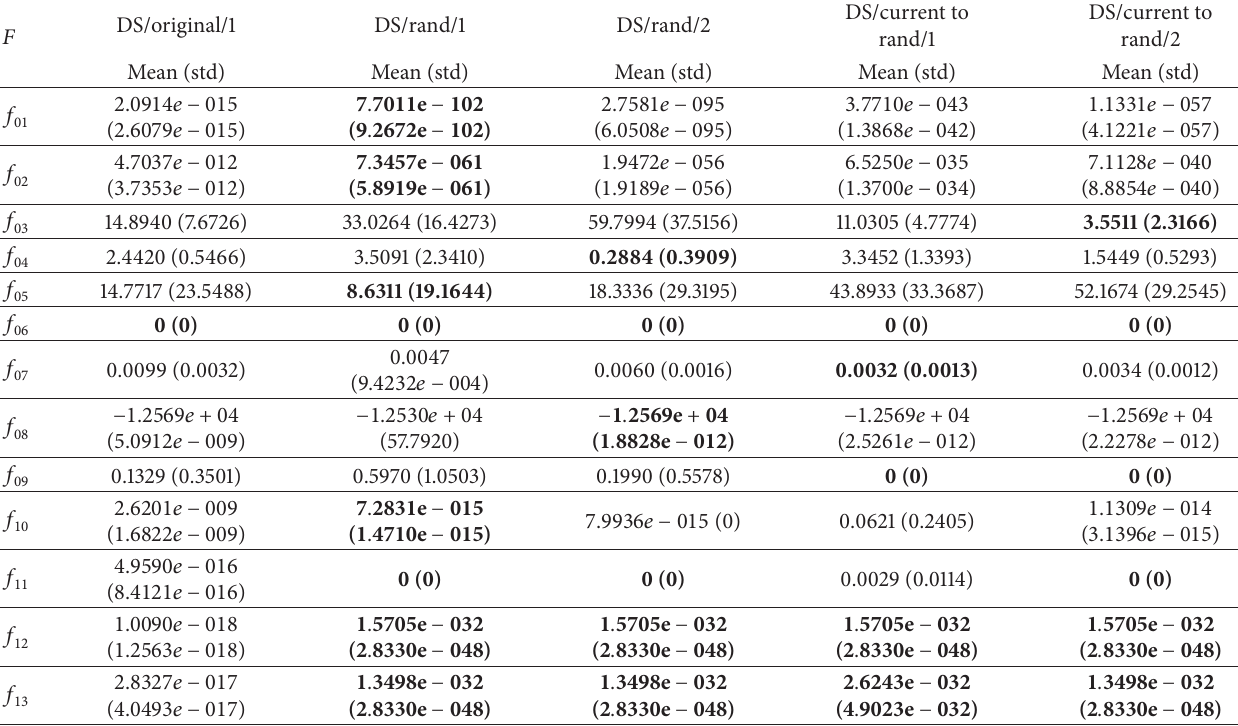
Table 6: Comparisons of different schemes with population size